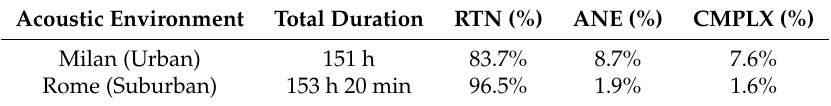
Table 2. General characteristics of the WASN-based urban and suburban acoustic databases evaluated considering the impact analysis